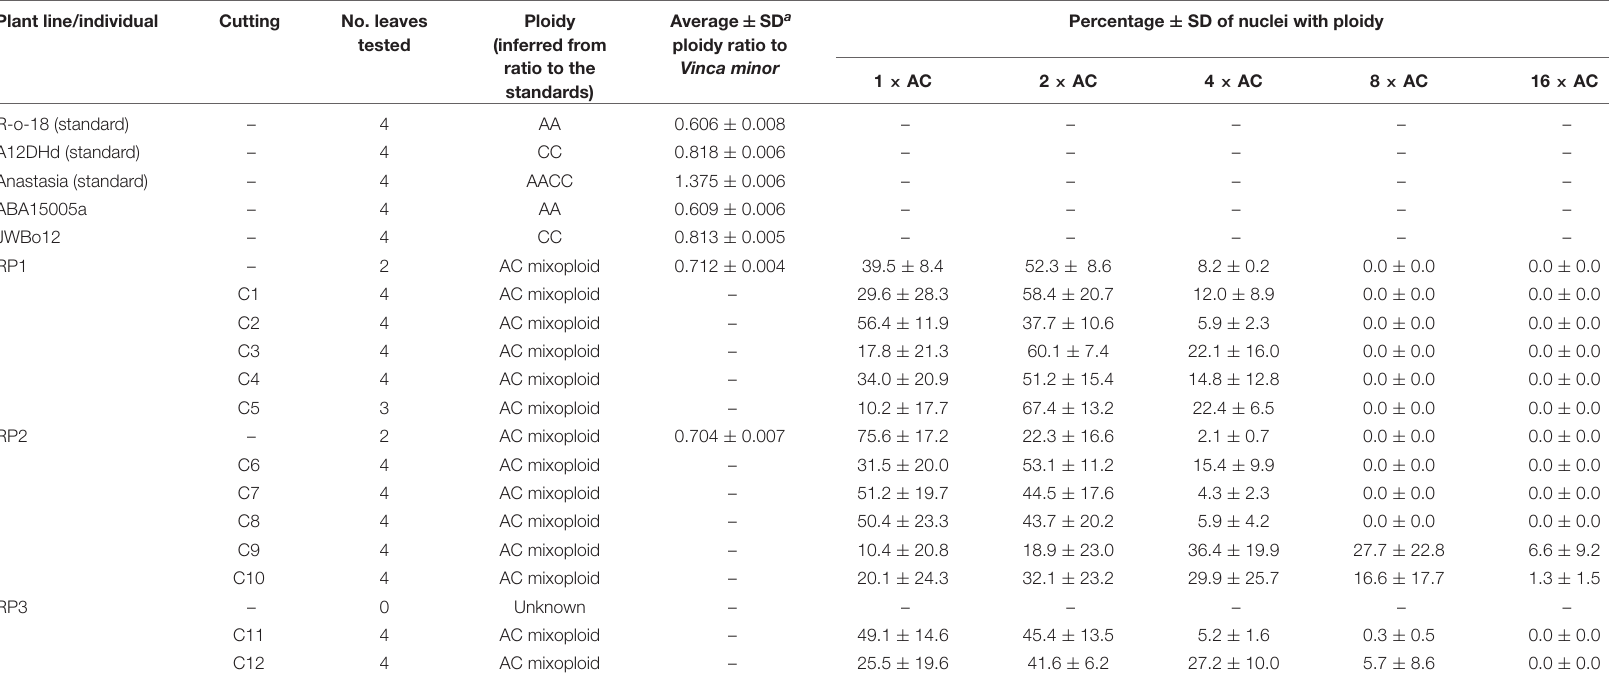
TABLE 2 | Ploidy of colchicine-treated cuttings (C1–12) taken from regenerated plantlets (RP1–3), produced from the interspecific cross of TuYV-resistant lines ABA15005a ( B. rapa ) and JWBo12 ( B. oleracea ). Plant line/individual Cutting No. leaves